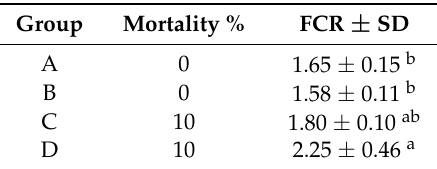
Table 1. Mortality % and feed conversion rate (FCR) at seven days post challenge with very virulent infectious bursal disease virus